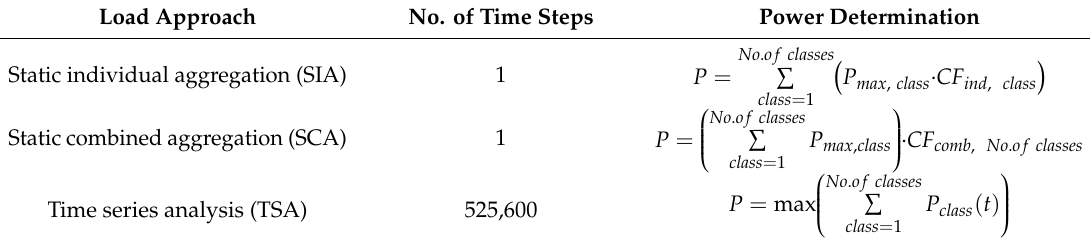
Table 3. Comparison of various load approaches applied for grid